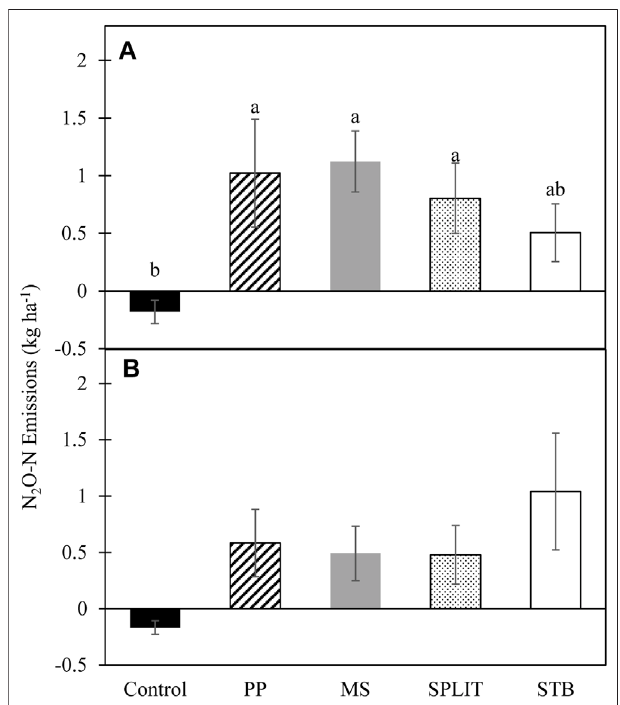
termination to cotton harvest in (A) 2016 and (B) 2017. LSM letters are different at p < 0.05, error bars represent standard error. PP, pre-plant nitrogen (N) fertilizer application; MS, mid-season N fertilizer application (applied at pinhead square); SPLIT, 40% PP 60% MS N fertilizer application; STB, 100% PP application with N stabilizer